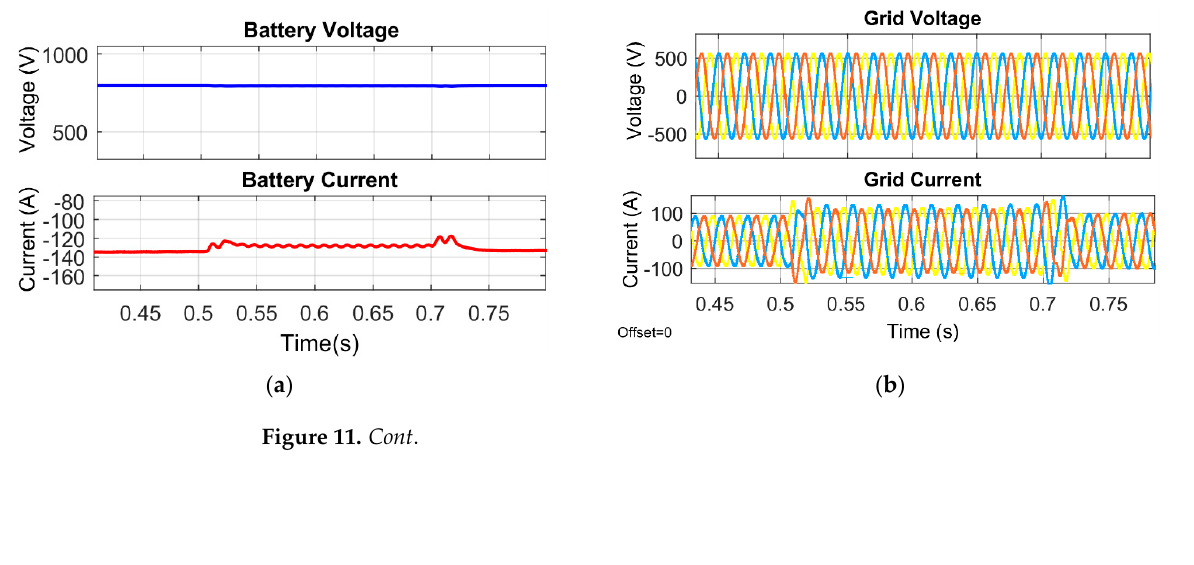
Figure 10. Response of the system parameters under non-linear load conditions. ( a ) Battery voltage and current under non-linear load condition, ( b ) Grid voltage and current under non-linear load condition, ( c ) Load voltage and current under non-linear load condition, and ( d ) THD under non- linear load condition.